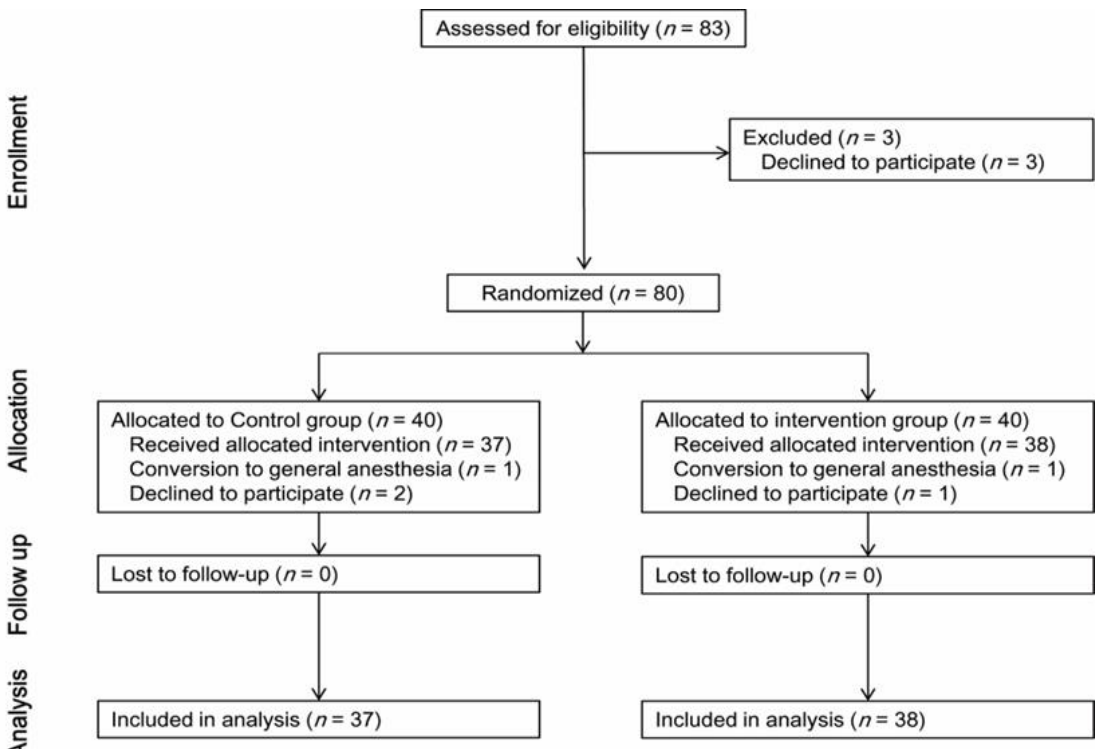
Figure 1. Flow chart of patient selection.